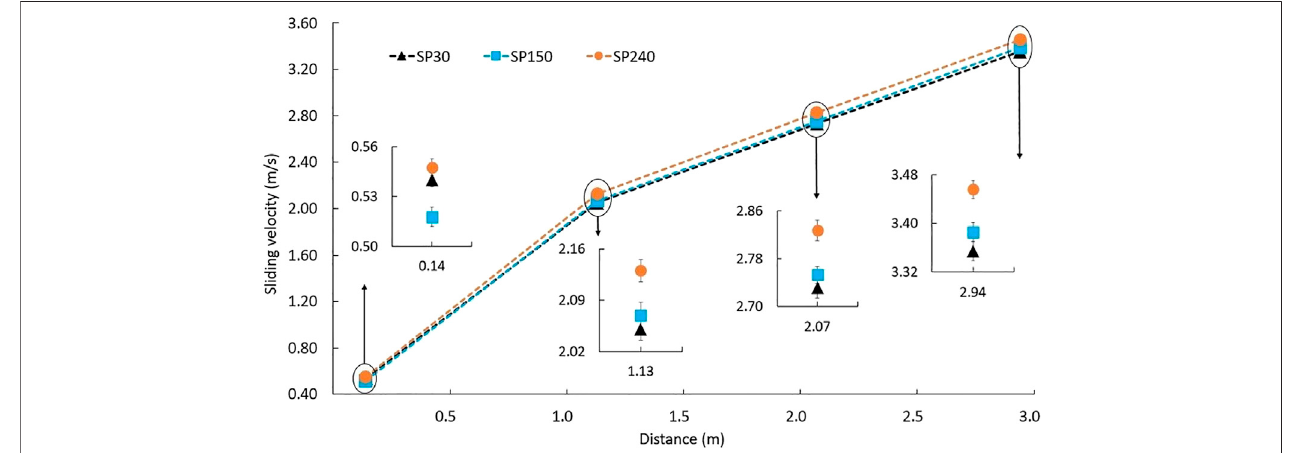
FIGURE 10 | Sliding velocities measured on the inclined plane tribometer. Sample velocity increases due to accelerated movement down the inclined plane. In the magni fi edcloseups,thesmoothestsampleSP240 isfasterthansamplesSP30andSP150,whichshowsimilar velocities.Slightlydifferentbehaviorbetweenthelatteris observed only in the fi rst measurement point, where the roughest sample SP30 is faster than the intermediately rough sample SP150.